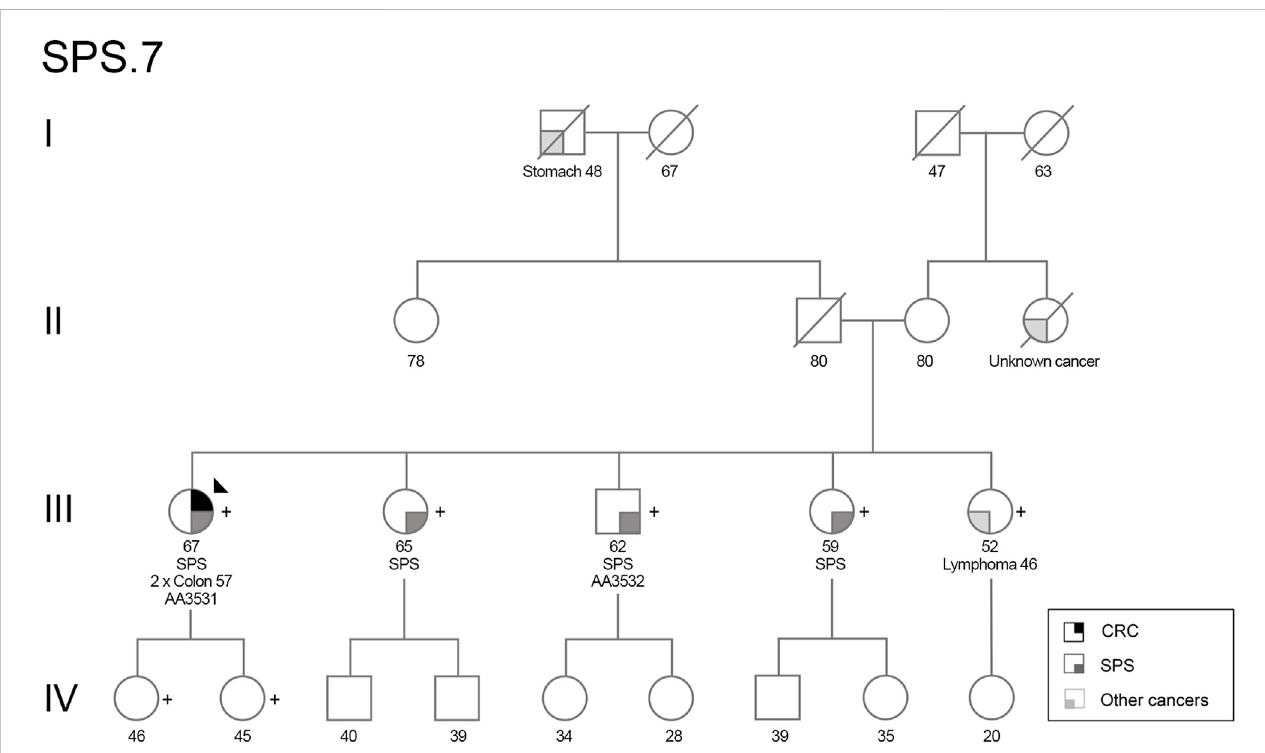
FIGURE 1 Pedigree of family SPS.7. Filled symbol indicates affected for CRC (upper right quarter), SPS (lower right quarter) or other types of cancer (lower left quarter). Stomach, colon and lymphoma refer to the type of cancer. The proband is indicated by an arrow, and POLD1 p.Lys648fs*46 variant carriers are indicated by (+). Ages at diagnosis are depicted. CRC, colorectal cancer; SPS, serrated polyposis syndrome.